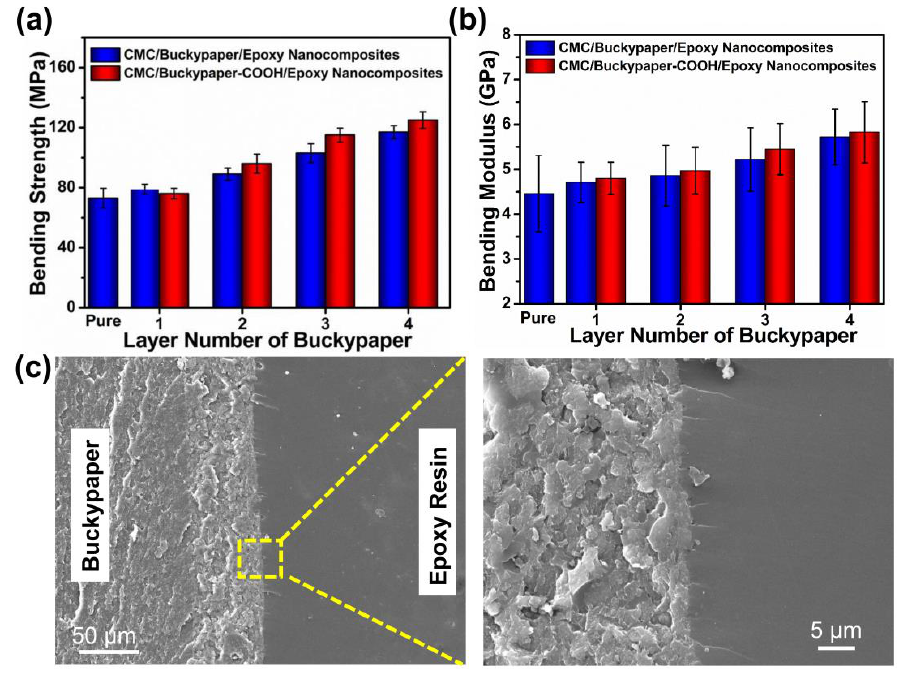
Figure 7. The mechanical properties of buckypaper nanocomposites. ( a ) bending strength; ( b ) bending modulus; ( c ) SEM pictures of fracture surfaces after bending test.